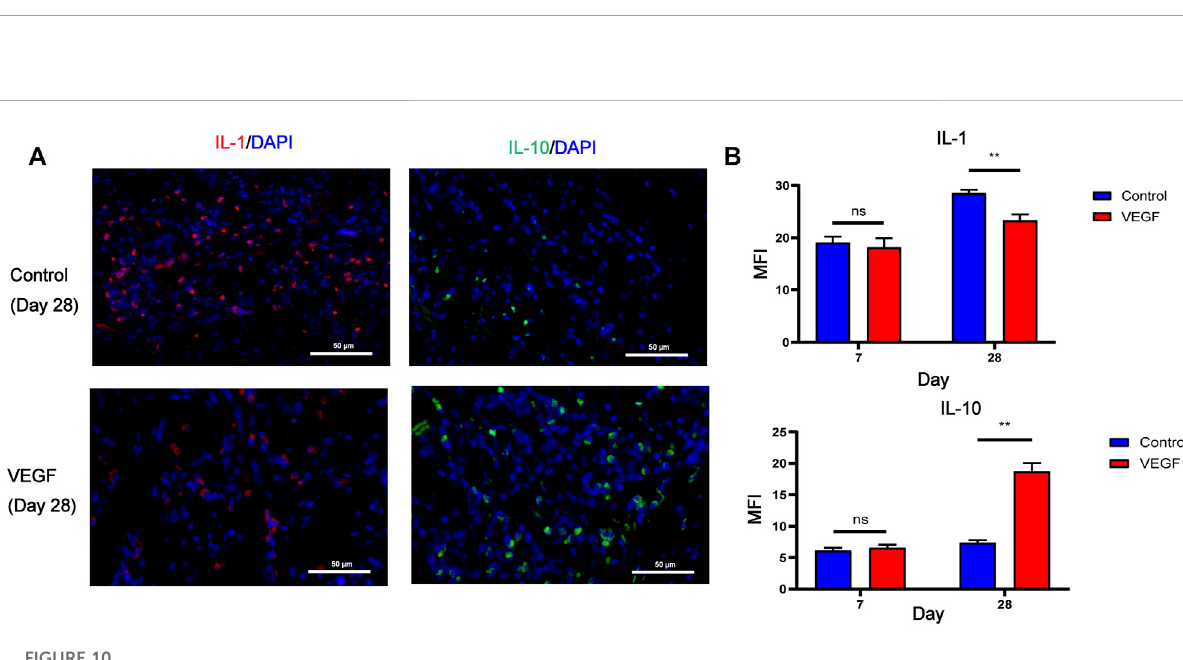
FIGURE 10 Representative immuno fl uorescence images of IL-1 and IL-10 expression of vascular grafts at day 28 in each group. IL-1 stained in red, IL-10 stained in green (A) . Immuno fl uorescence quanti fi cation of IL-1 and IL-10 (B) . MFI, mean fl uorescence intensity. * p < 0.05. ** p < 0.01. ns represents no signi fi cant